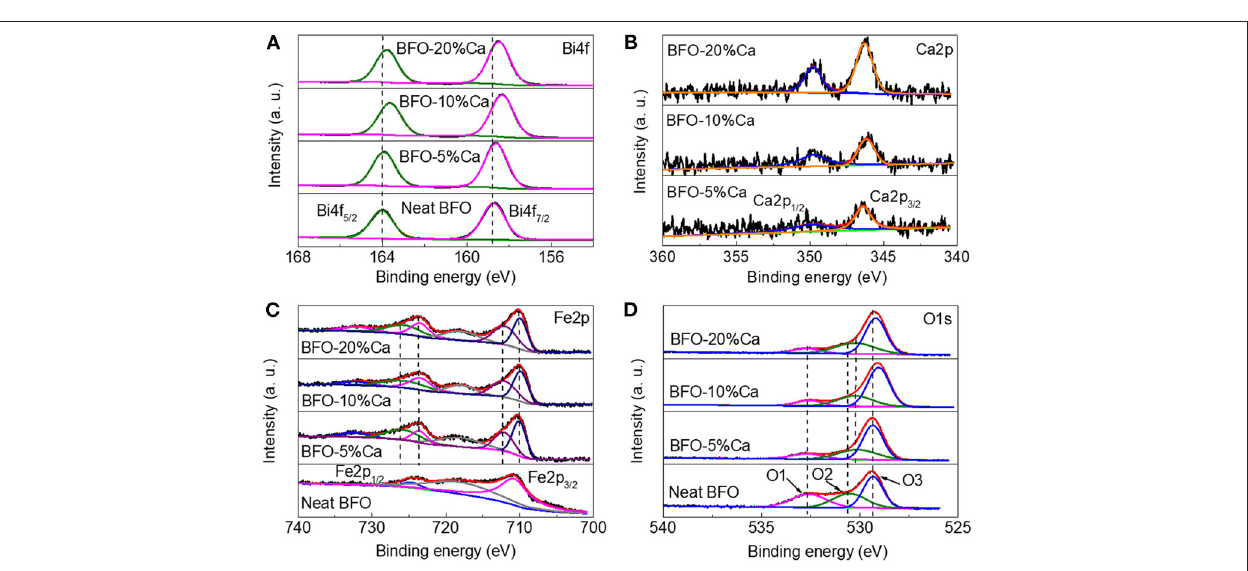
FIGURE 4 | XPS spectra of BFO, BFO-5%Ca, BFO-10%Ca, and BFO-20%Ca, (A) Bi4f peak, (B) Ca2p peak, (C) Fe2p peak, and (D) O1s peak.